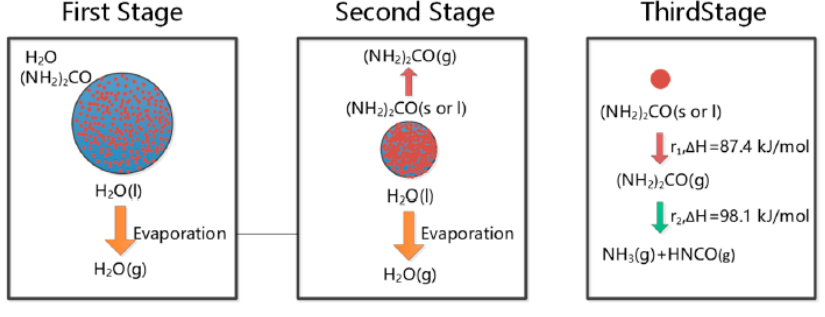
Figure 3. Urea pyrolysis mechanism [19]